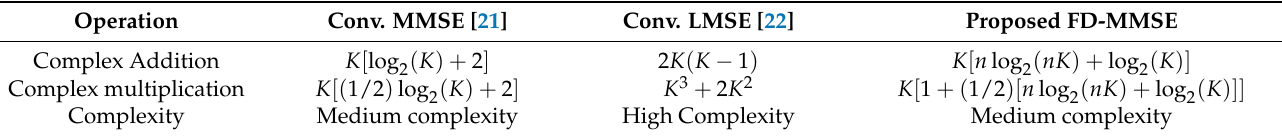
Table 2. Complexity